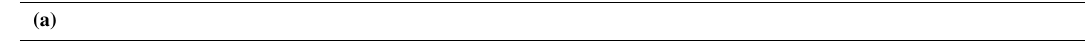
Table 3. (a) Types of RSL indicators used in the NW Europe database. (b) Practical scheme for SLIP type choice, as developed during data